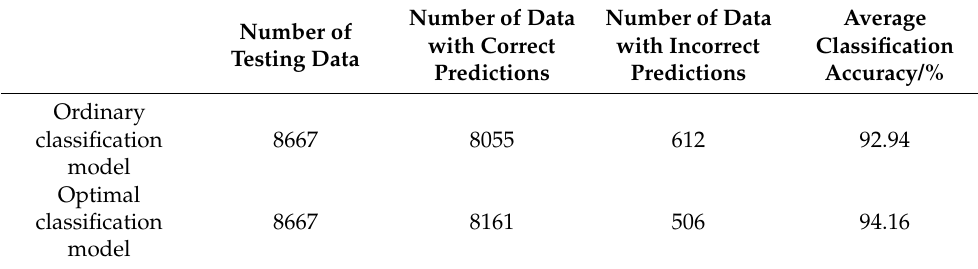
Table 9. Classification accuracies achieved by the classification model based on kNN before and after parameter